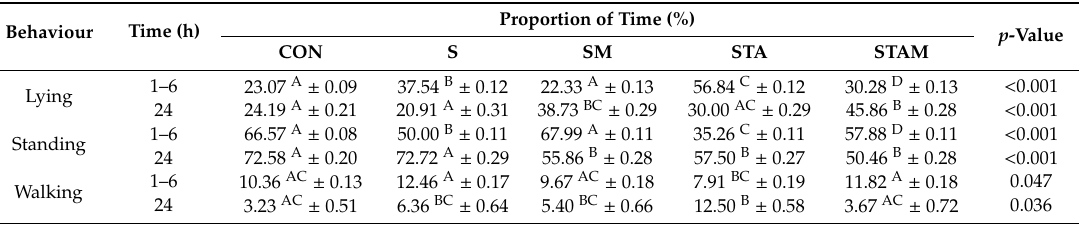
Table 3. Proportion of time spent lying down, standing and walking ( ± SE) by heifers in each treatment group at 1–6 h and 24 h